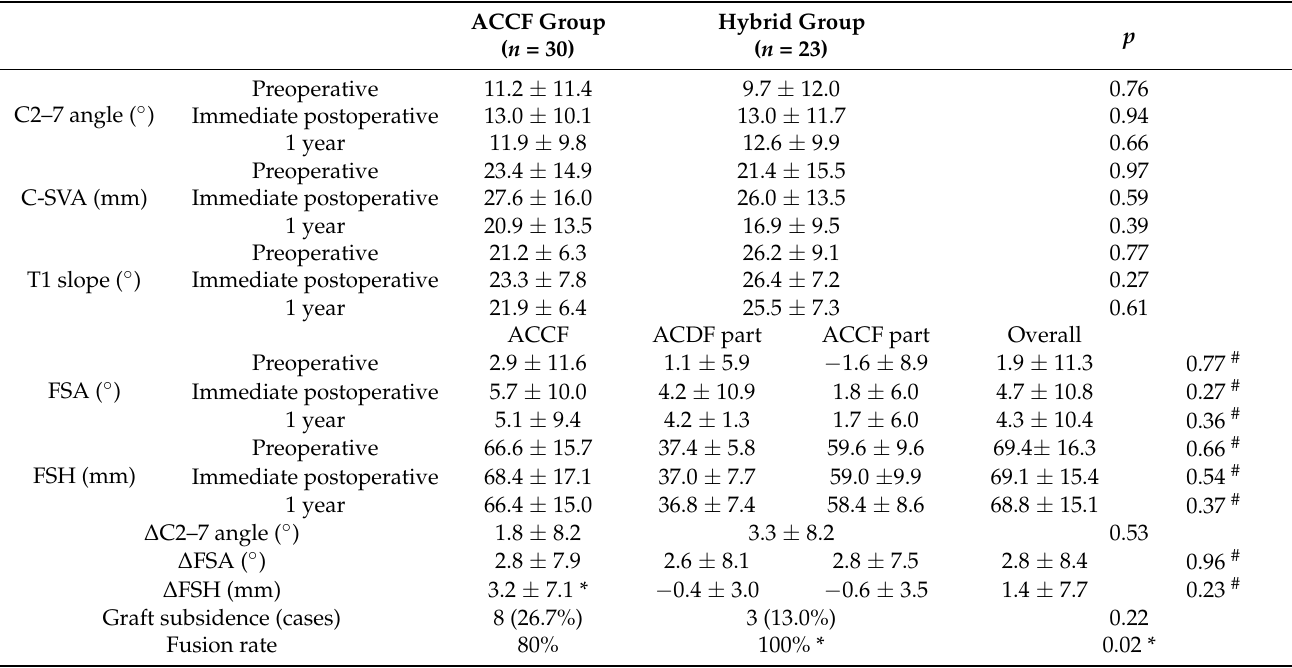
Table 4. Radiologic outcomes in the ACCF and hybrid